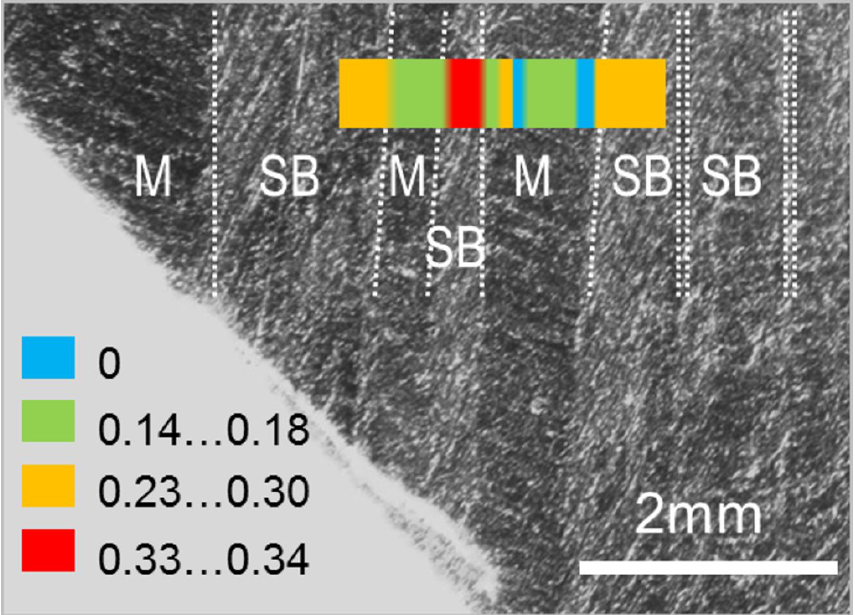
Figure 3. Local distribution of the microstrain in a line scan across three shear bands of the material in the ECAP condition; the region of interest is shown with respect to the deformation localizations shown by grain boundary etching (for color-coding, see